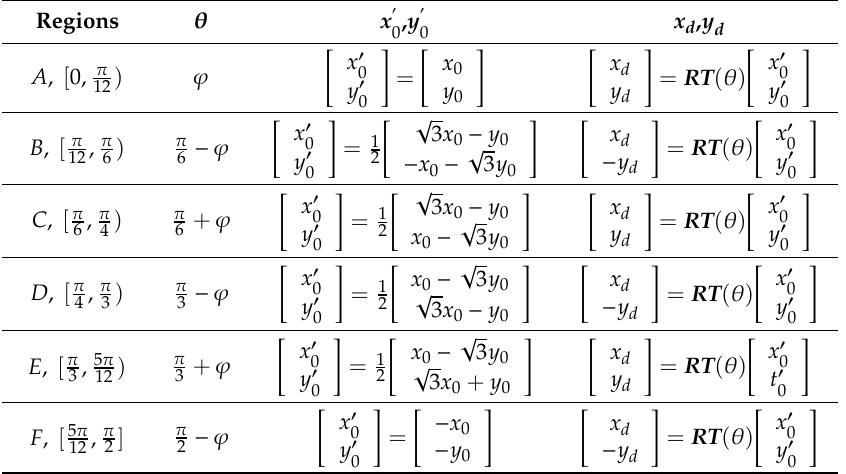
Table 1. The CORDIC output mappings between θ and ϕ